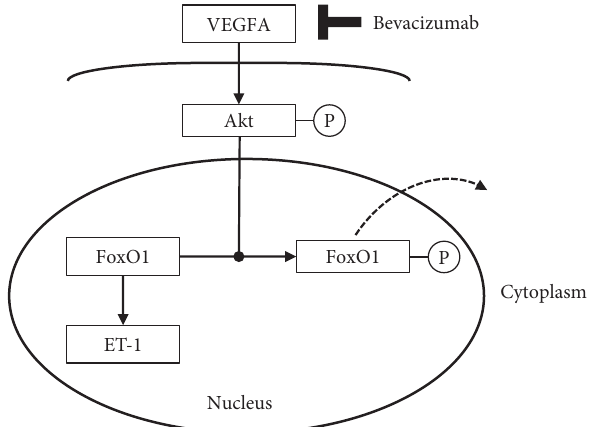
Figure 5: A schematic showing signaling pathways that increase ET-1 production on FoxO1 nuclear localization induced by bev- acizumab in human glomerular microvascular endothelial cells (hGECs). Abbreviations: VEGFA, vascular endothelial growth factor A; Akt, protein kinase B; FoxO1, forkhead box protein O1; ET-1,